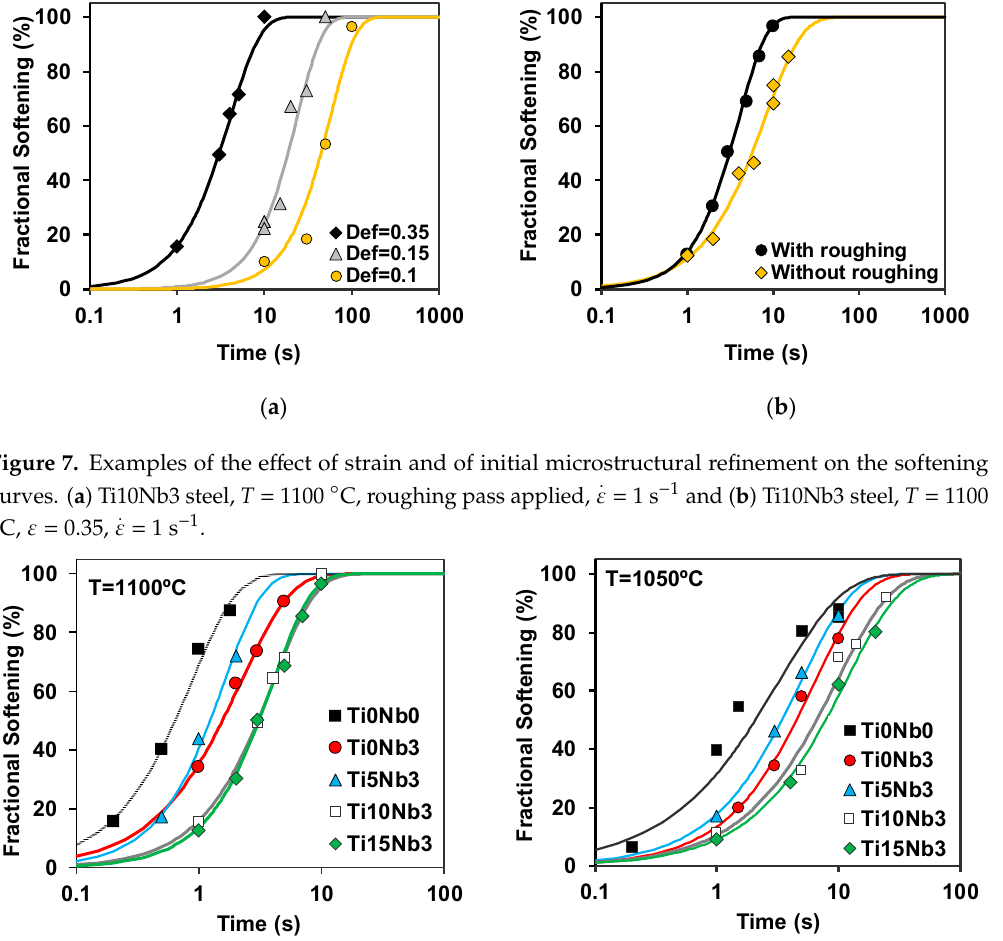
Figure 7. Examples of the effect of strain and of initial microstructural refinement on the softening curves. ( a ) Ti10Nb3 steel, T = 1100 °C, roughing pass applied, 𝜀(cid:4662) =1 s − 1 and ( b ) Ti10Nb3 steel, T = 1100 °C, 𝜀 = 0.35, 𝜀(cid:4662) = 1 s − 1 .